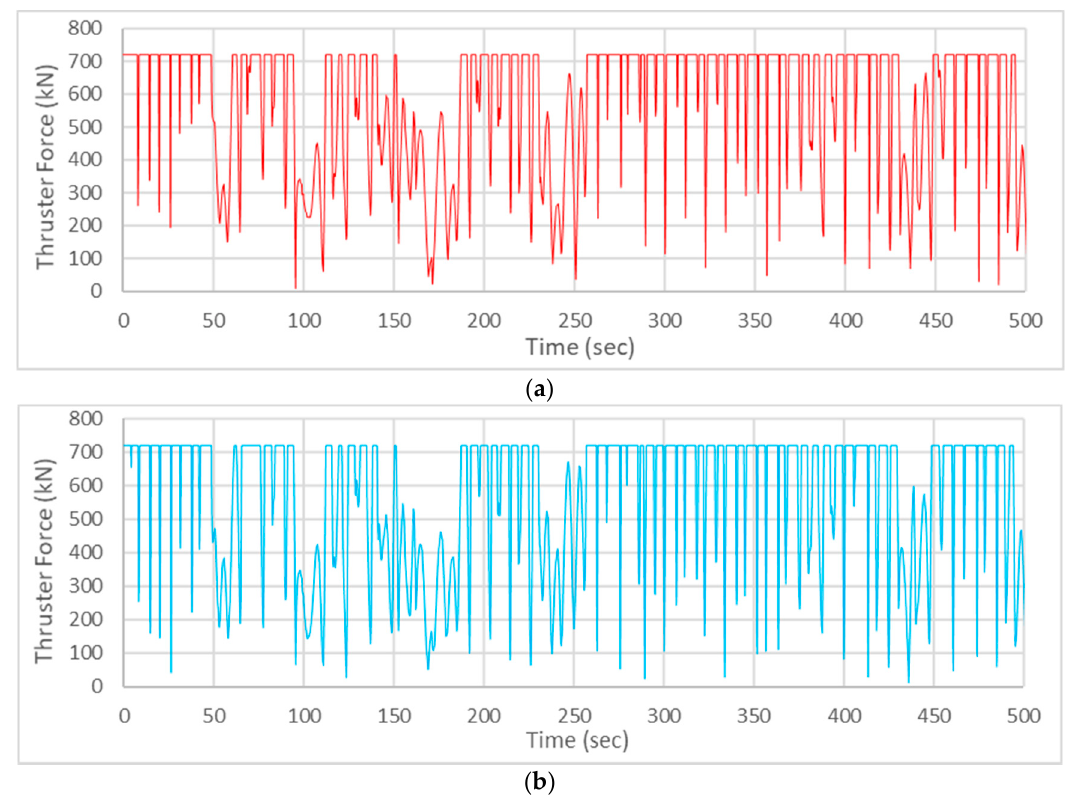
Figure 11. DP simulation with PID control showing thruster force: ( a ) Thruster 3; ( b ) Thruster 6. Further comparison was made of this study ′ s results with those of Reference [20], which reported the performance of a smaller semisubmersible model at a required position and heading x = − 4 m, y = − 3 m and ψ = 0 degrees within a 2000 s time-frame, as shown in Figure 12.